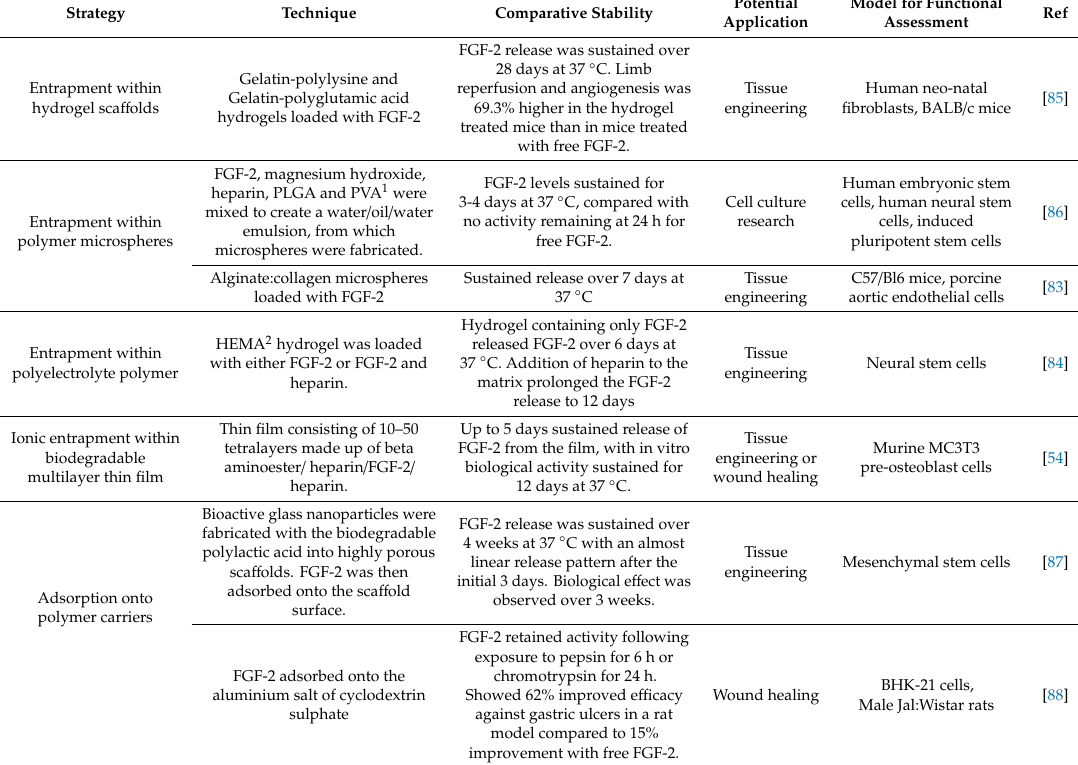
Table 3. Examples of physical protective methods to stabilise and / or prolong the biological activity of FGF-2. Strategy Technique Comparative